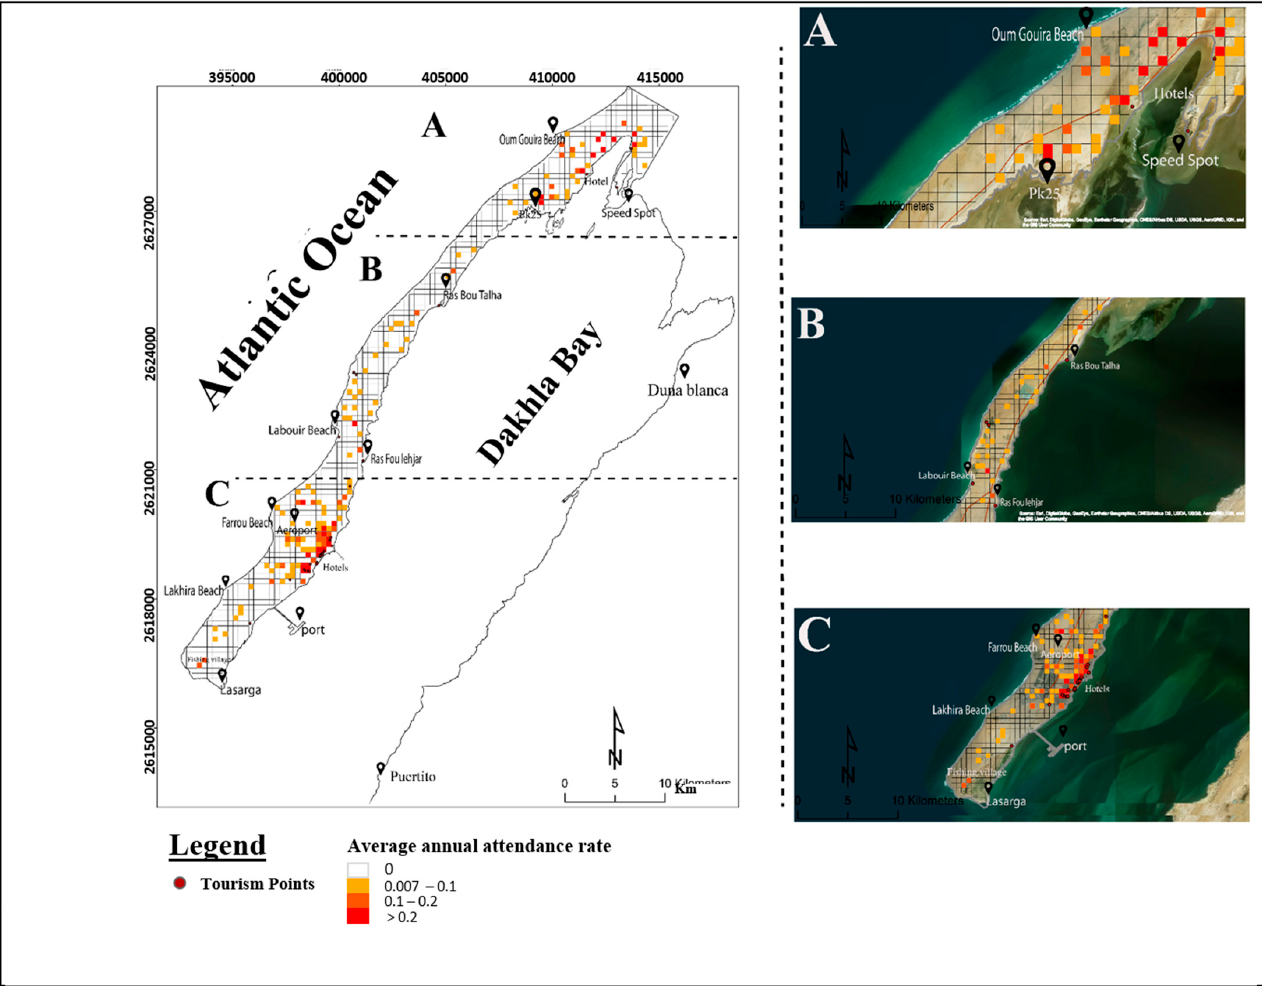
Figure 3. Average annual visit rate per cell grid across Dakhla Bay (Sub figures ( A – C ) are close ups of sections A,B,C in the main map).